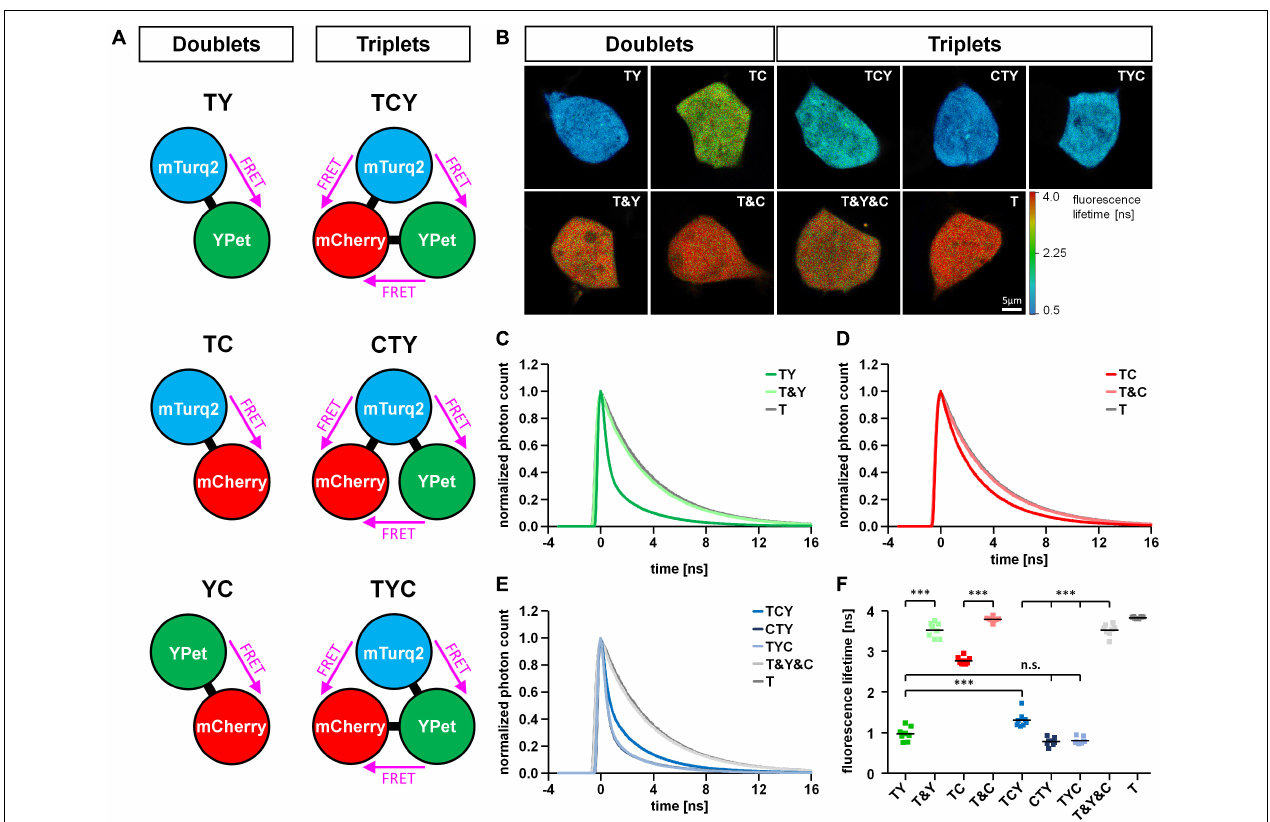
FIGURE 1 | Basal properties of FRET triplet and doublet constructs. (A) Schematic drawing of FRET doublet and FRET triplet constructs composed of a combination of the fluorophores mTurquoise2 (T), YPet (Y) and mCherry (C). Note that within the triplet constructs, FRET can occur in three different directions. (B) Representative fluorescence lifetime images of FRET doublet (TY, TC) and FRET triplet constructs (TCY, CTY, TYC) expressed in HEK293T cells in comparison to the respective negative controls (T&Y, T&C, T&Y&C) and the FRET donor alone (T). (C–E) Average decay profiles of mTurquoise2 for different conditions ( n = 8). The decay profile of the TY doublet shows a clear FRET-induced left shift compared to the negative control (T&Y) and the donor alone (T) (C) . The left shift observed in the TC doublet was less prominent (D) . FRET-induced left shifts of the fluorescence decay observed in the FRET triplets was different depending on the position of T, Y and C within the linear construct (E) . (F) Average amplitude weighted lifetimes of all FRET constructs, their respective negative controls and the FRET donor mTurquoise2 alone ( n = 8). Note the differences in lifetime reduction according to the type of interacting fluorophores in the FRET doublets (TY, TC) or the positioning of the fluorophores within the FRET triplet constructs (TCY, CTY,